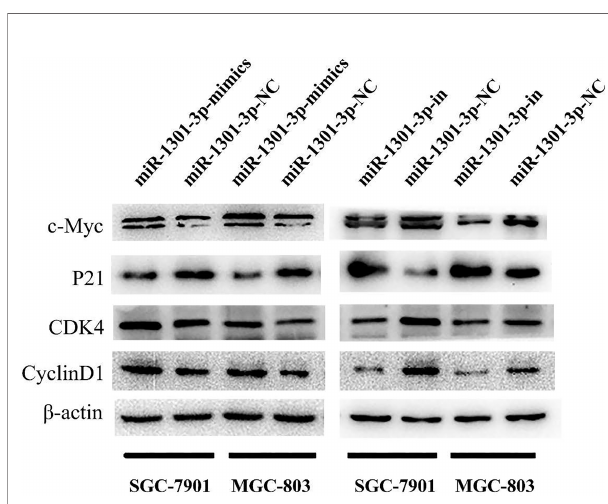
FIGURE 5 | Expression of key proteins for G1/S transition. Overexpression of miR-1301-3p elevated the Cyclin D1, CDK4, c-Myc expression and inhibited P21 expression, knockdown of miR-1301-3p inhibited Cyclin D1, CDK4, c-Myc expression and elevated P21 expression.